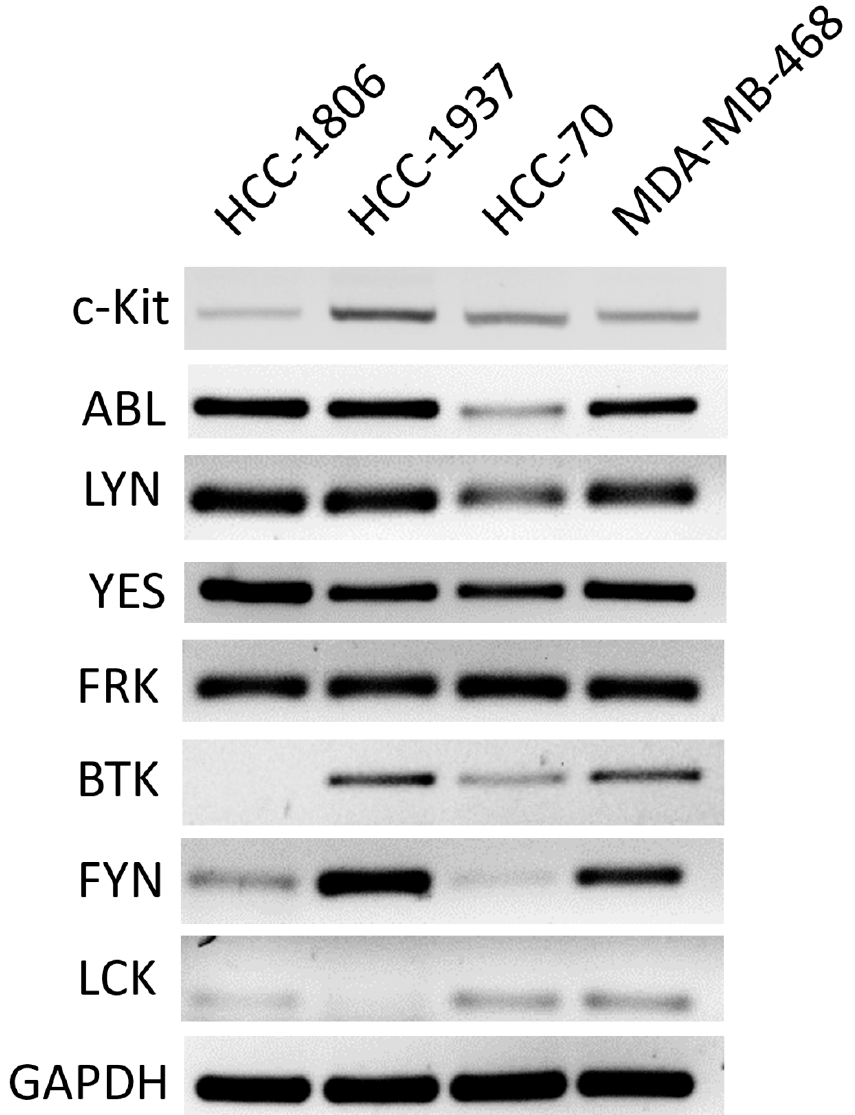
Figure 5. Expression of Receptor Tyrosine Kinases (RTKs) and intracellular tyrosine kinases in TNBC cell lines. Total RNA was isolated from HCC-1806, HCC-1937, HCC-70, and MDA-MB-468 cells. The expression of c-Kit, ABL, LYN, YES, FRK, BTK, FYN, and LCK was evaluated by RT-PCR.